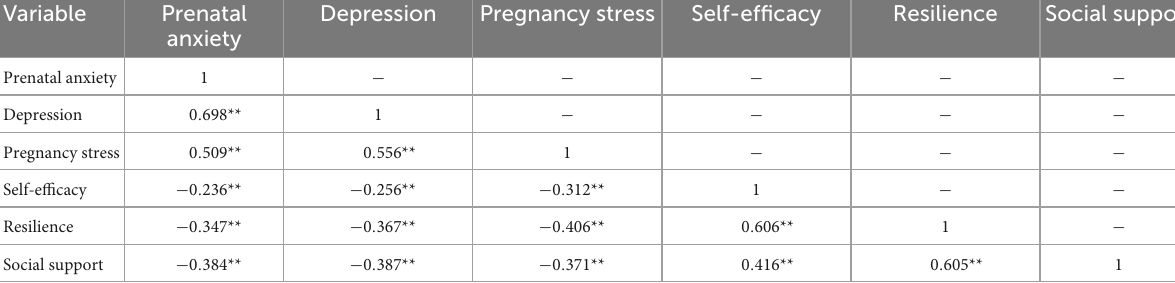
TABLE 4 Correlation analysis of positive psychology and negative emotion of pregnant